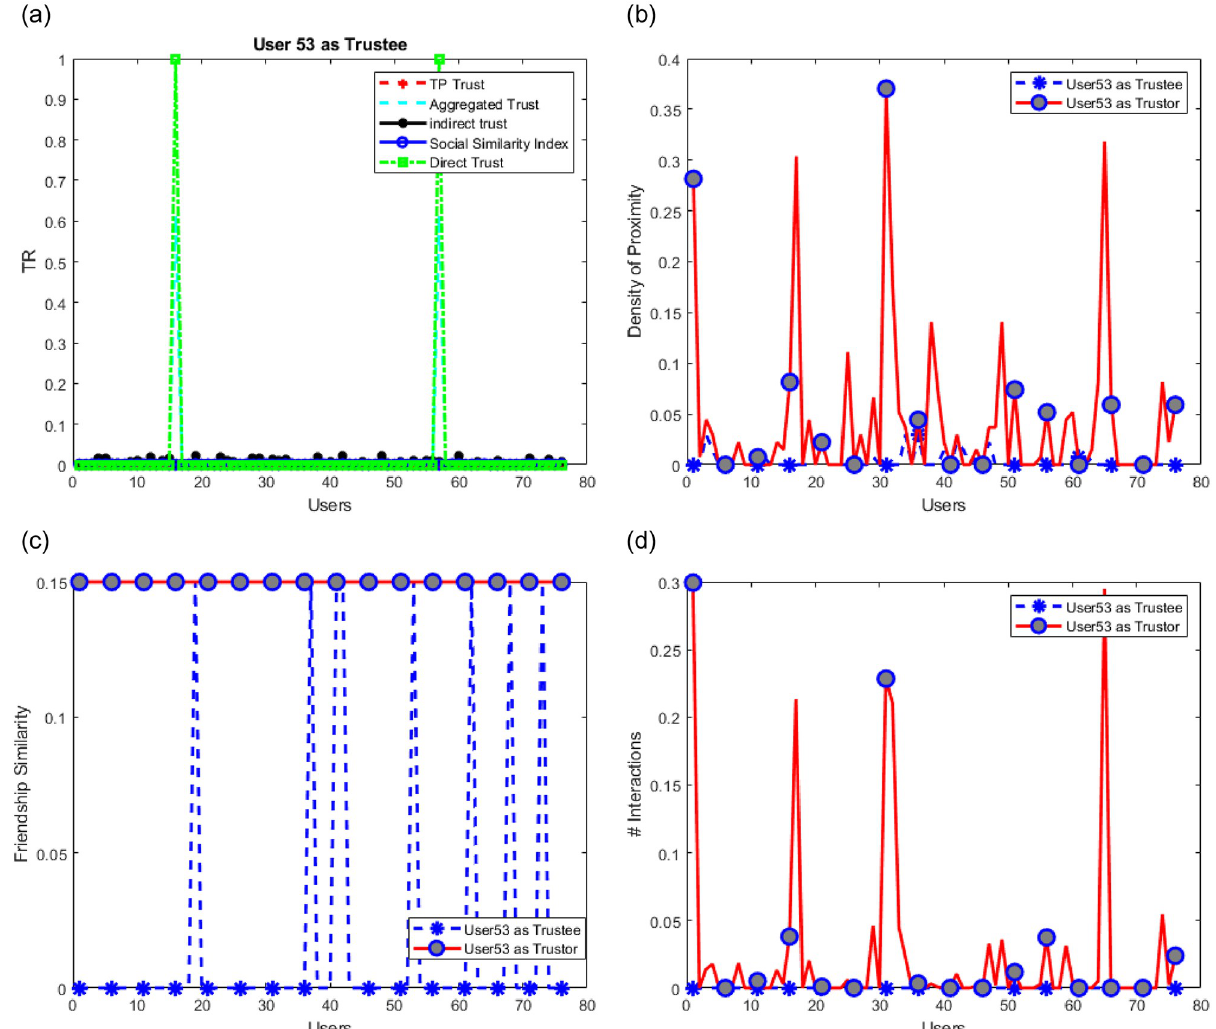
Fig 14. User 53 trust features before an attack. (a) user 53 predicted trust before an attack, (b) User53 proximity to other users, (c) User 53 low centrality at all to other users, (d) Low interactions with user 53 before an attack.